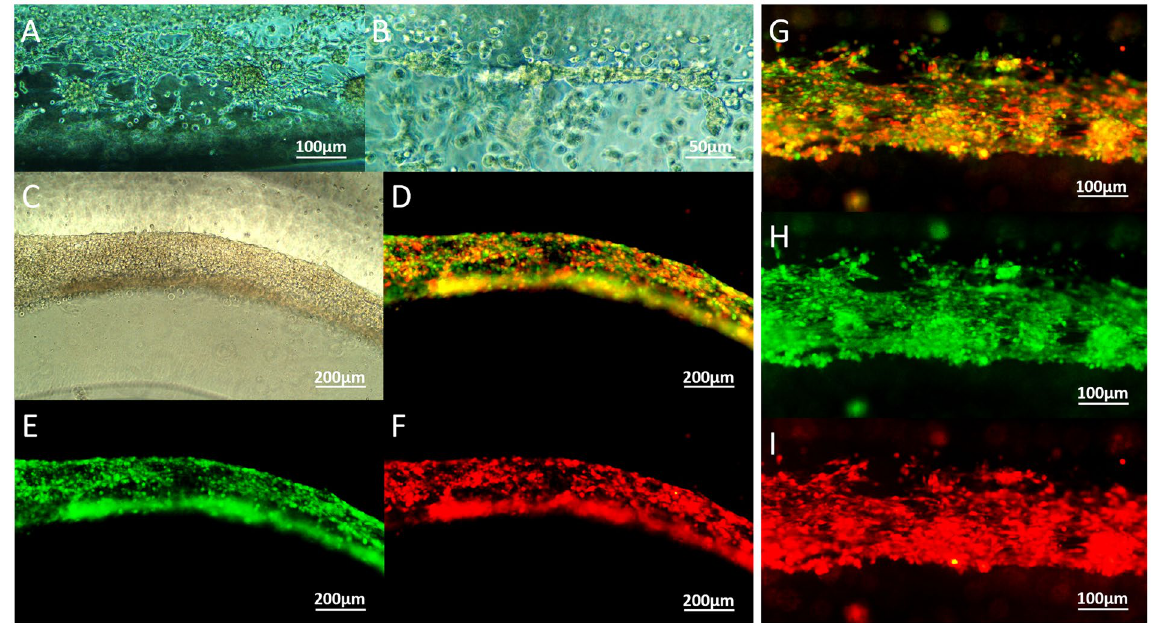
Figure 6. RFP/GFP traced tumor/stroma cell fibers. ( A , B ) Tumor cells and stroma cells fused into flakes and strands on day 2; ( C – F ) Cell fibers containing RFP-expressing tumor cells and GFP-expressing MSCs after